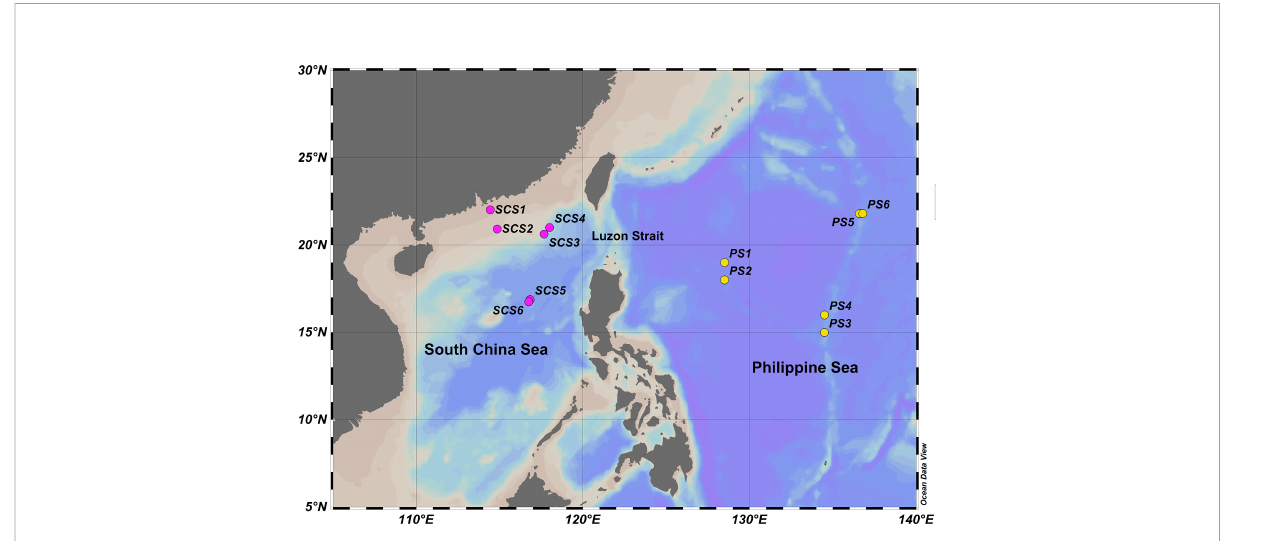
FIGURE 1 Locations of sampling sites used for